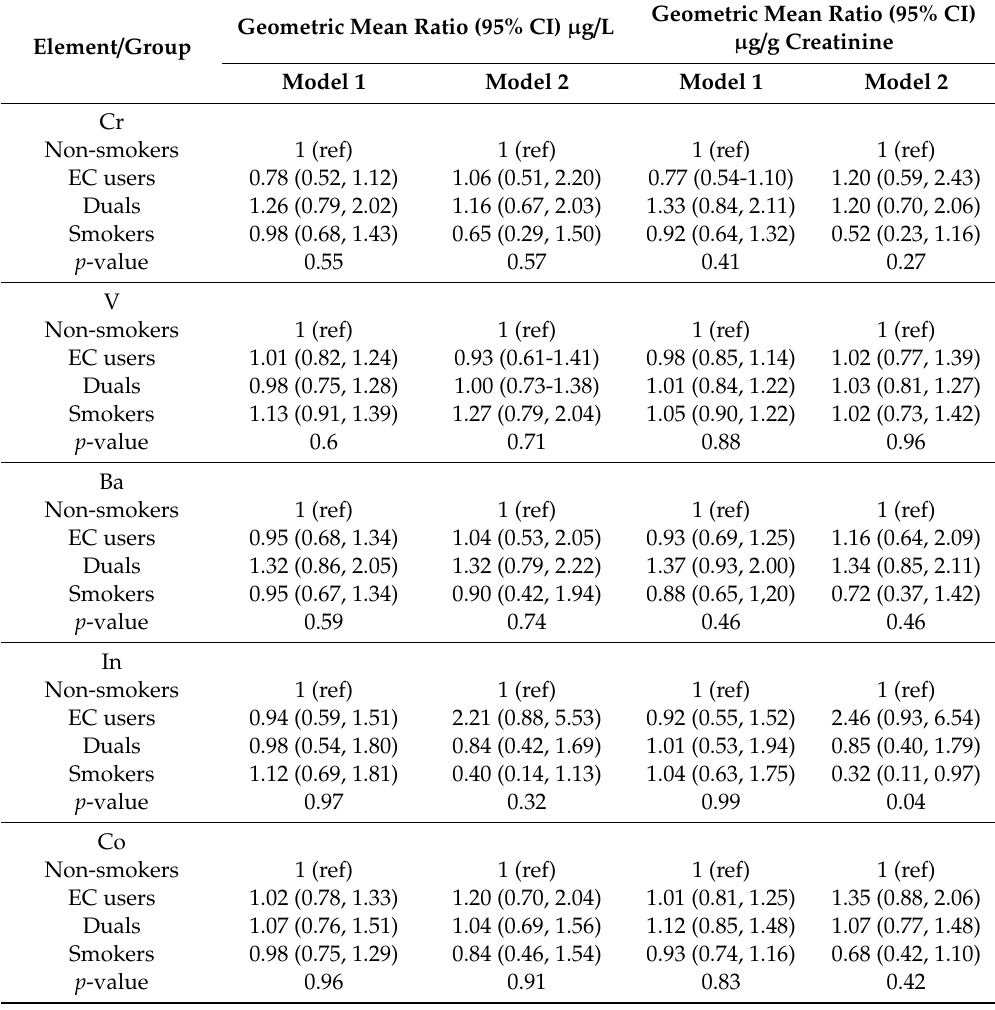
Table 3. Ratio of geometric means (95% confidence interval-CI) in Models 1 and 2 with non-smokers as a reference group